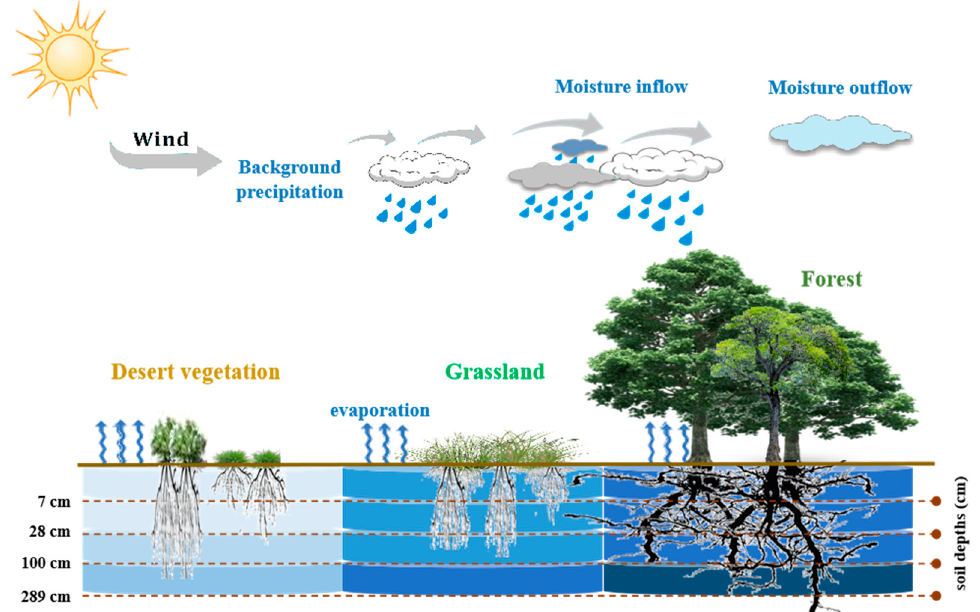
Figure 10. Schematic diagram of relationship between the NDVI and various depth soil moisture under different vegetation types.